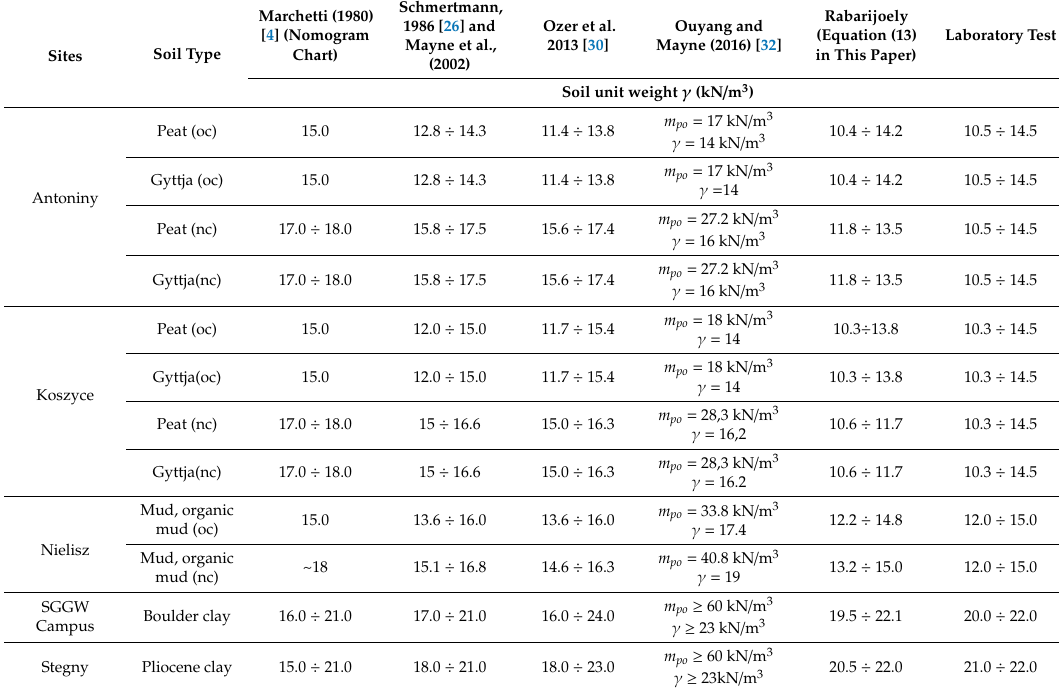
Table 10. Comparison of results obtained based on empirical correlations in the literature with results calculated by the proposed formula (Equation (13)) and the results from laboratory